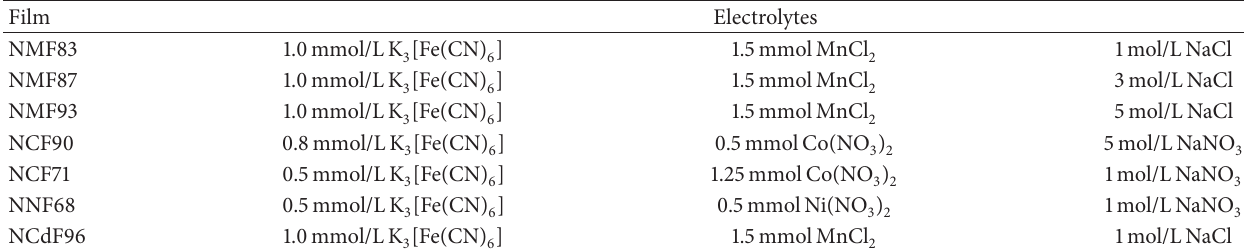
] 0.81 3.0H 2 O, Na 1.48 Mn 6